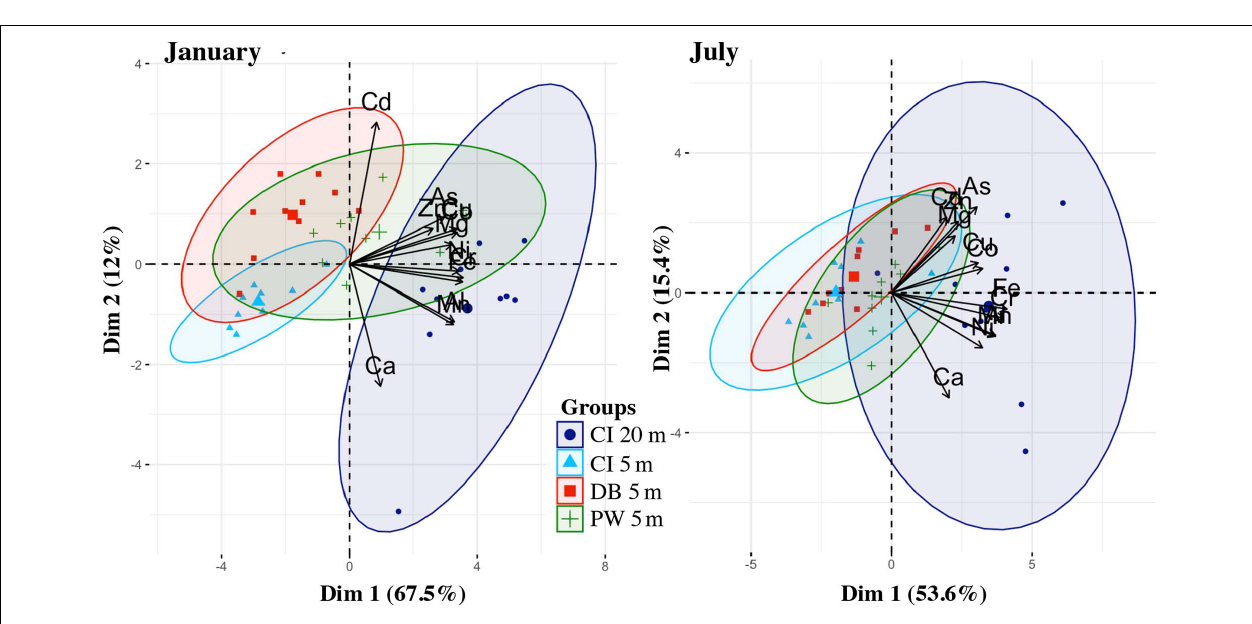
FIGURE 13 | PCA of the trace metals data from mussels from January and July, colored by location (Carr Inlet 20 m = dark blue, Carr Inlet 5 m = light blue, Dabob Bay 5 m = red, Point Wells 5 m =